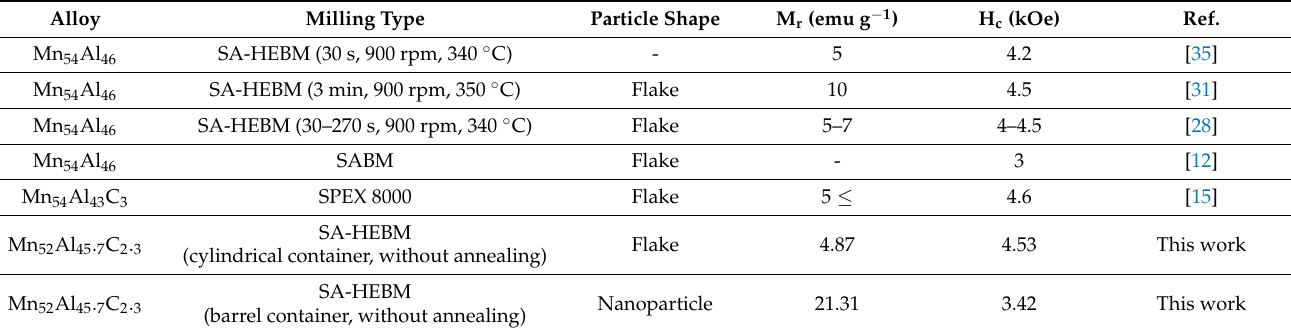
Table 4. Comparison of magnetic properties of MnAl alloys with different milling